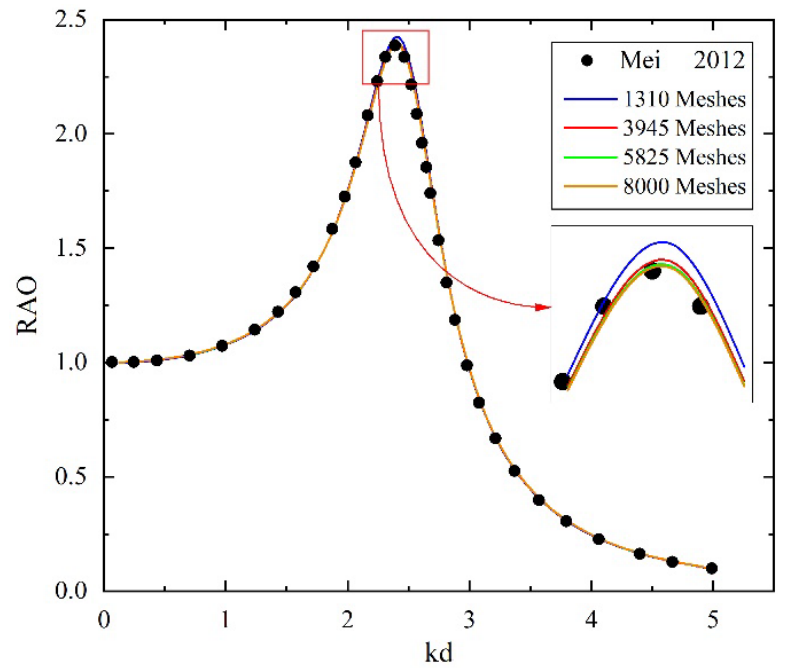
Figure 5. The simulation results are verified with the results published by Mei